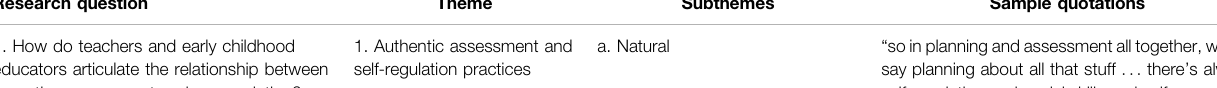
TABLE 2 | Overview of themes and subthemes. Please note that ‘ T ’ represents a teacher participant and ECE represents an early childhood educator. Research